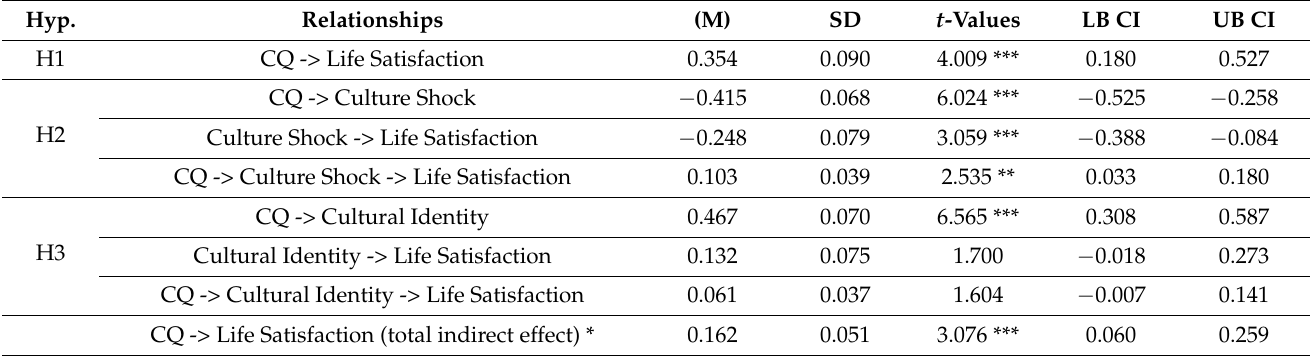
Table 2. Test of